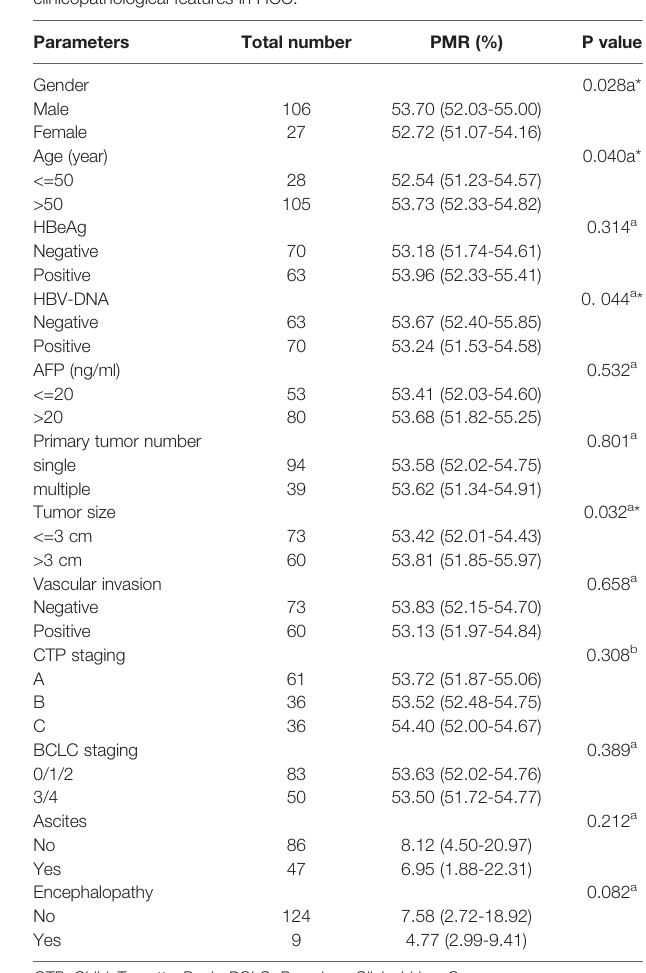
TABLE 3 | Associations between IL-6 promoter methylation levels and clinicopathological features in